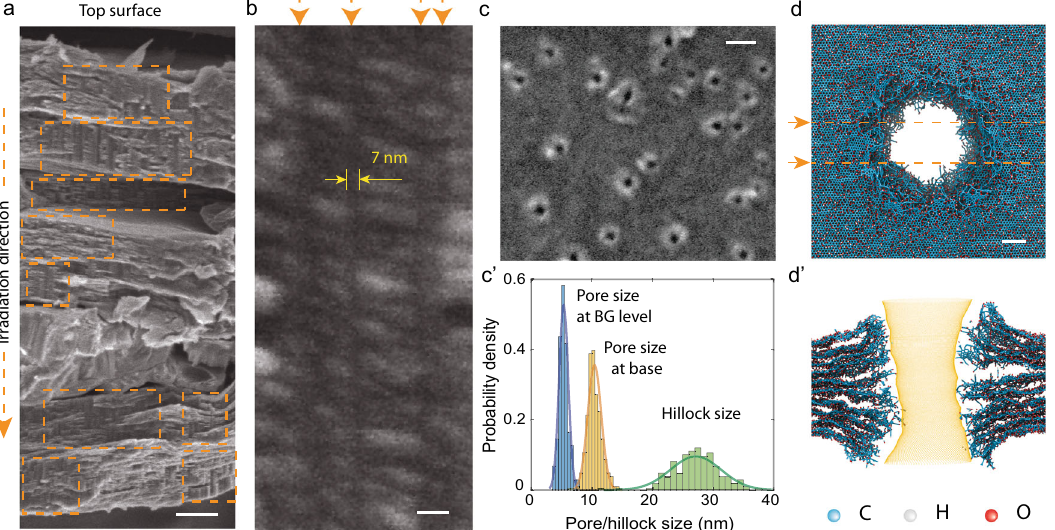
Fig.2|UltralongstraightnanochannelsformedinGO fi lms.a , b Cross-sectional SEM images of a GO-Z specimen (sputter coated with Pt/Pd) irradiated with 710MeV Bi ions to a fl uence of 1×10 11 ionscm − 2 at a low and b high magni fi cation. c SEM image of the surface of the 710MeV Bi ion-irradiated GO-Z fi lm. c ’ Normal- ized distributions of pore and hillock sizes, determined as described in